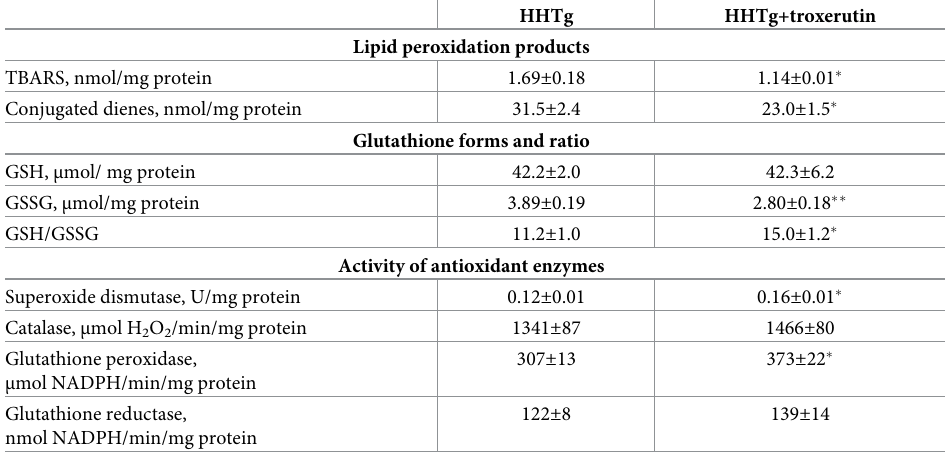
Table 2. Oxidative stress parameters in the liver of HHTg rats supplemented with troxerutin. HHTg HHTg+troxerutin Lipid peroxidation products TBARS, nmol/mg protein 1.69 ± 0.18 1.14 ± 0.01 � Conjugated dienes, nmol/mg protein 31.5 ± 2.4 23.0 ± 1.5 � Glutathione forms and ratio GSH, μ mol/ mg protein 42.2 ± 2.0 42.3 ± 6.2 GSSG, μ mol/mg protein 3.89 ± 0.19 2.80 ± 0.18 �� GSH/GSSG 11.2 ± 1.0 15.0 ± 1.2 � Activity of antioxidant enzymes Superoxide dismutase, U/mg protein 0.12 ± 0.01 0.16 ± 0.01 � Catalase, μ mol H 2 O 2 /min/mg protein 1341 ± 87 1466 ± 80 Glutathione peroxidase, 307 ± 13 373 ± 22 � μ mol NADPH/min/mg protein Glutathione reductase, 122 ± 8 139 ± 14 nmol NADPH/min/mg protein Values are mean ± SEM for each group, n = 8 for both group � p < 0.05 �� p <